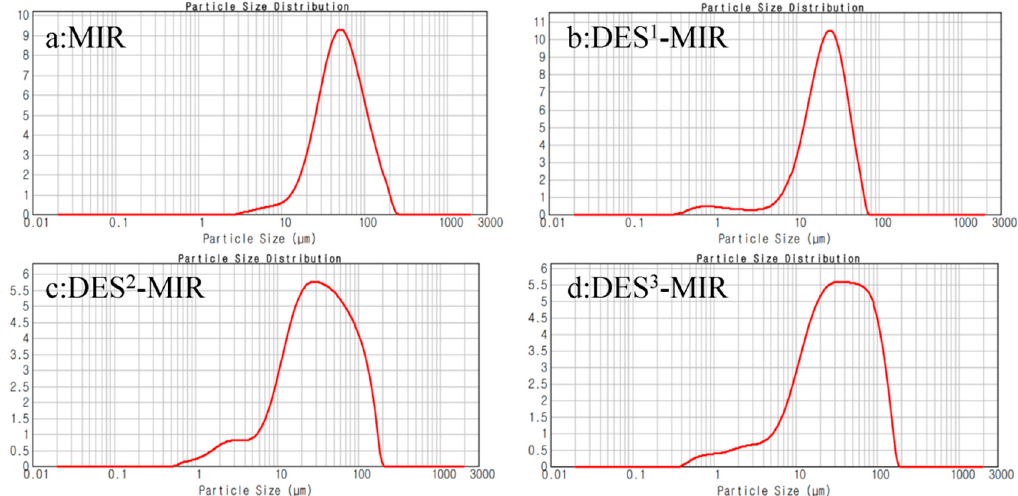
Figure 5. Particle size distribution of ( a ) MIR, ( b ) DES 1 -MIR, ( c ) DES 2 -MIR and ( d ) DES 3